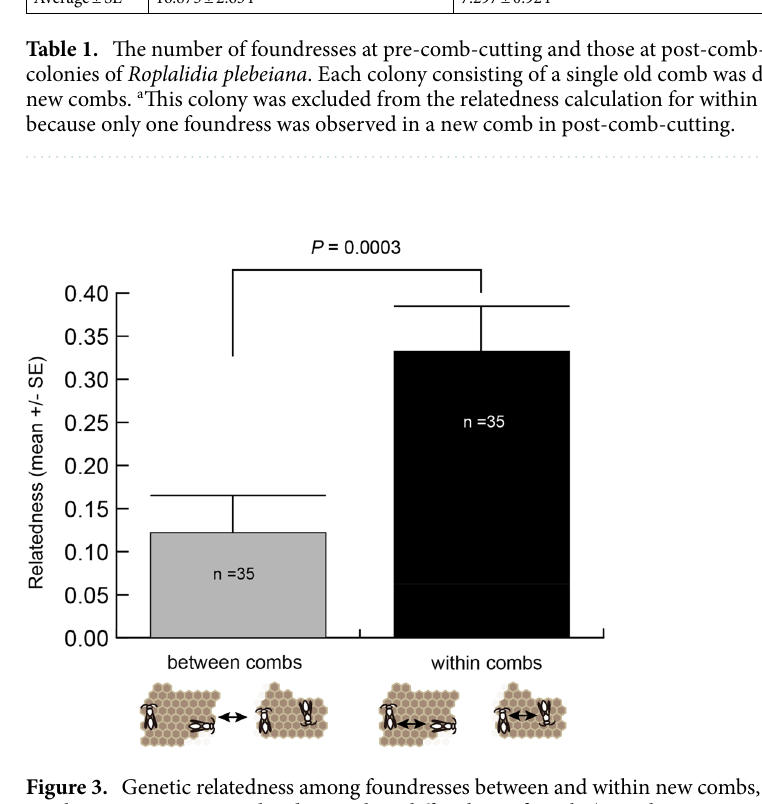
Figure 3. Genetic relatedness among foundresses between and within new combs, who settled on the same old combs prior to cutting. Relatedness values differed significantly (paired t-test, P = 0.0003). Each arrow indicated the relationships for which each relatedness was